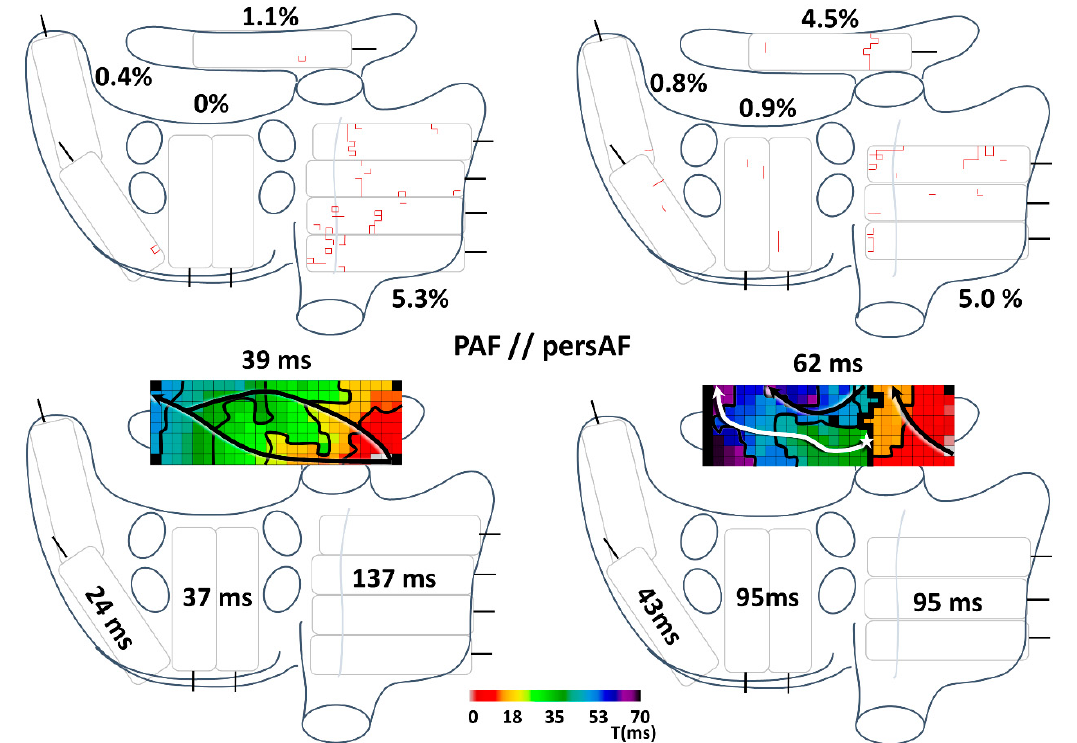
Figure 4. Typical paroxysmal and persistent AF patient. The distribution of CB prevalence (upper panel) and AT (lower panel) is seen in a PAF (left) and a persAF patient (right). In the lower panel, two activation maps are demonstrated at BB with 10 ms isochrones, arrows showing the direction of wavefront propagation and thick black lines indicating CB area. The paroxysmal AF patient, 69 years old, was diagnosed 3 months before he underwent mitral valve surgery. He had been experiencing palpitations for minutes to hours at a time and AF occurred during a cardiac exercise stress test while he experienced similar palpitations. The persistent AF patient, 64 years old, was diagnosed with AF 10 months before he underwent mitral valve surgery. As duration of AF was unknown at the time of diagnosis, an electrocardioversion was scheduled 2 months later, which was successful. The patient had two more AF episodes lasting longer than 7 days requiring electrocardioversion before surgery, which restored SR in both cases. CB: conduction block; PAF: paroxysmal AF; persAF: persistent AF; AT: activation time.